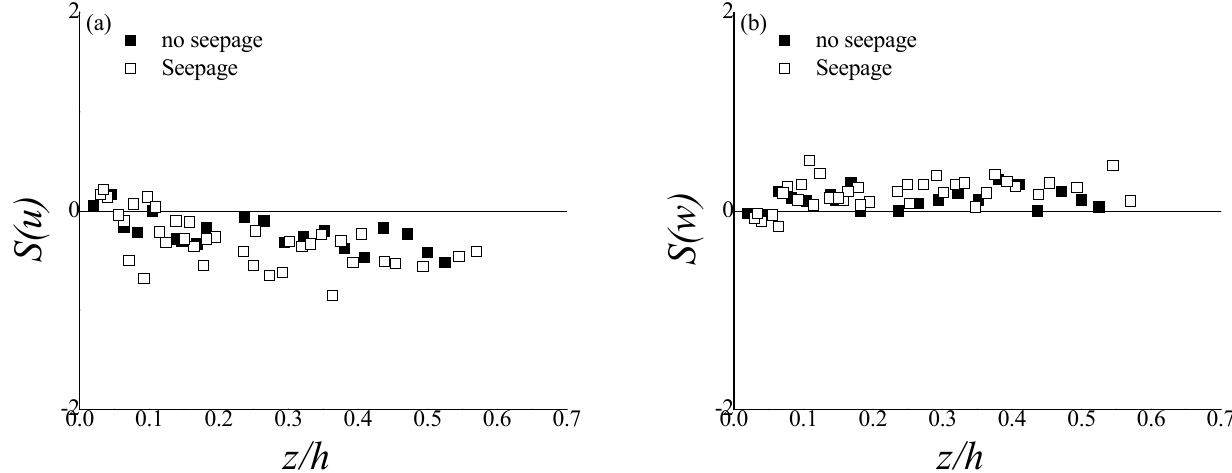
Figure 8. Profiles of skewness ( a ) S( u ) and ( b ) S( w ) for all experiments in this study.